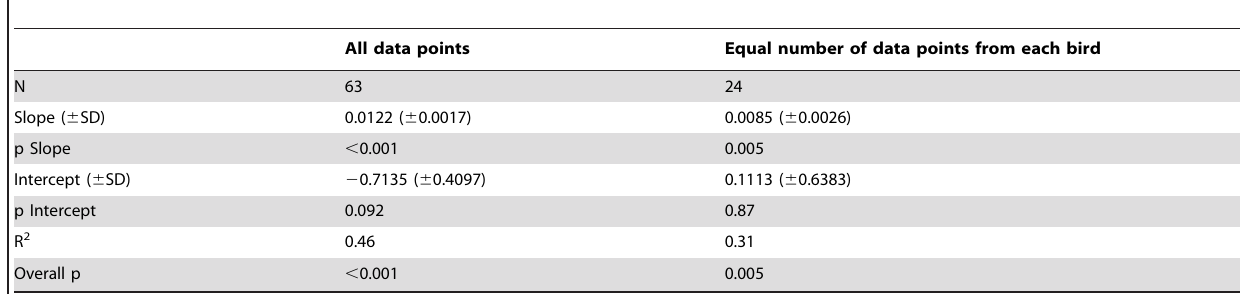
Table 2. Major axis type 2 regressions analysis 1 results from analysis of the association between the independent factor f H and the dependent factor _ VV O 2 in European